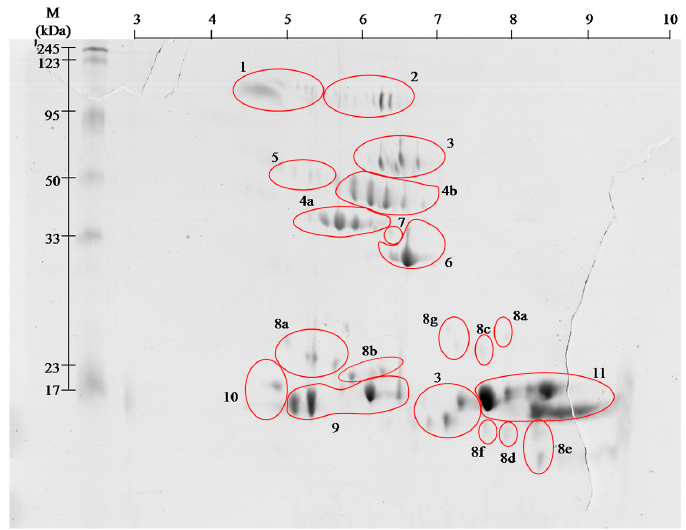
Figure 1. Representative 2-D protein map in 3–10 pH range, obtained from V. berus berus venom with identified protein groups shown: 1 , Angiotensin-like peptide; 2 , Metalloproteinase H3; 3 , L -amino acid oxidase; 4 , Serine proteases: ( a ) VLSp and ( b ) nikobin; 5 , Beta-fibrogenase brevinase; 6 , Cysteine rich venom protein; 7 , Snake venom metalloproteinases; 8 , Snaclec: ( a ) rhinocetin, ( b ) snaclec 14, ( c ) snaclec B6, ( d ) echicetin, ( e ) snaclec 1, ( f ) rhodocetin/A13, and ( g ) jerdonibitin; 9 , Acidic phospholipases; 10 , Basic phospholipases; and 11 , Neutral phospholipase. The proteins were separated by isoelectrofocusing at pH range 3–10, then distributed on polyacrylamide gels by SDS-PAGE and stained with colloidal Coomassie Brilliant Blue G-250. Molecular weight (MW) and pH 3–10 scale are